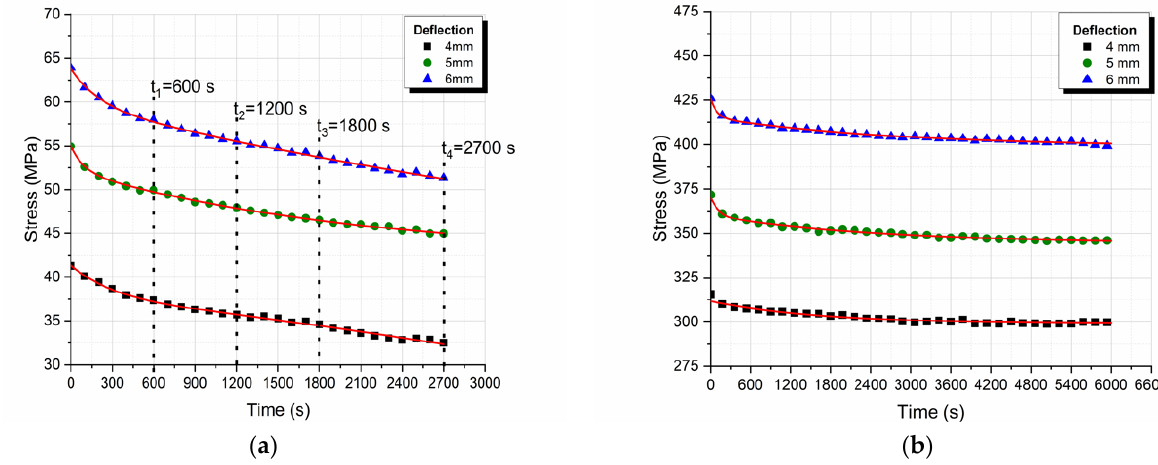
Figure 9. Stress relaxation curves ( a ) of the neat epoxy resin and ( b ) the GFRP composite for different deflection levels.